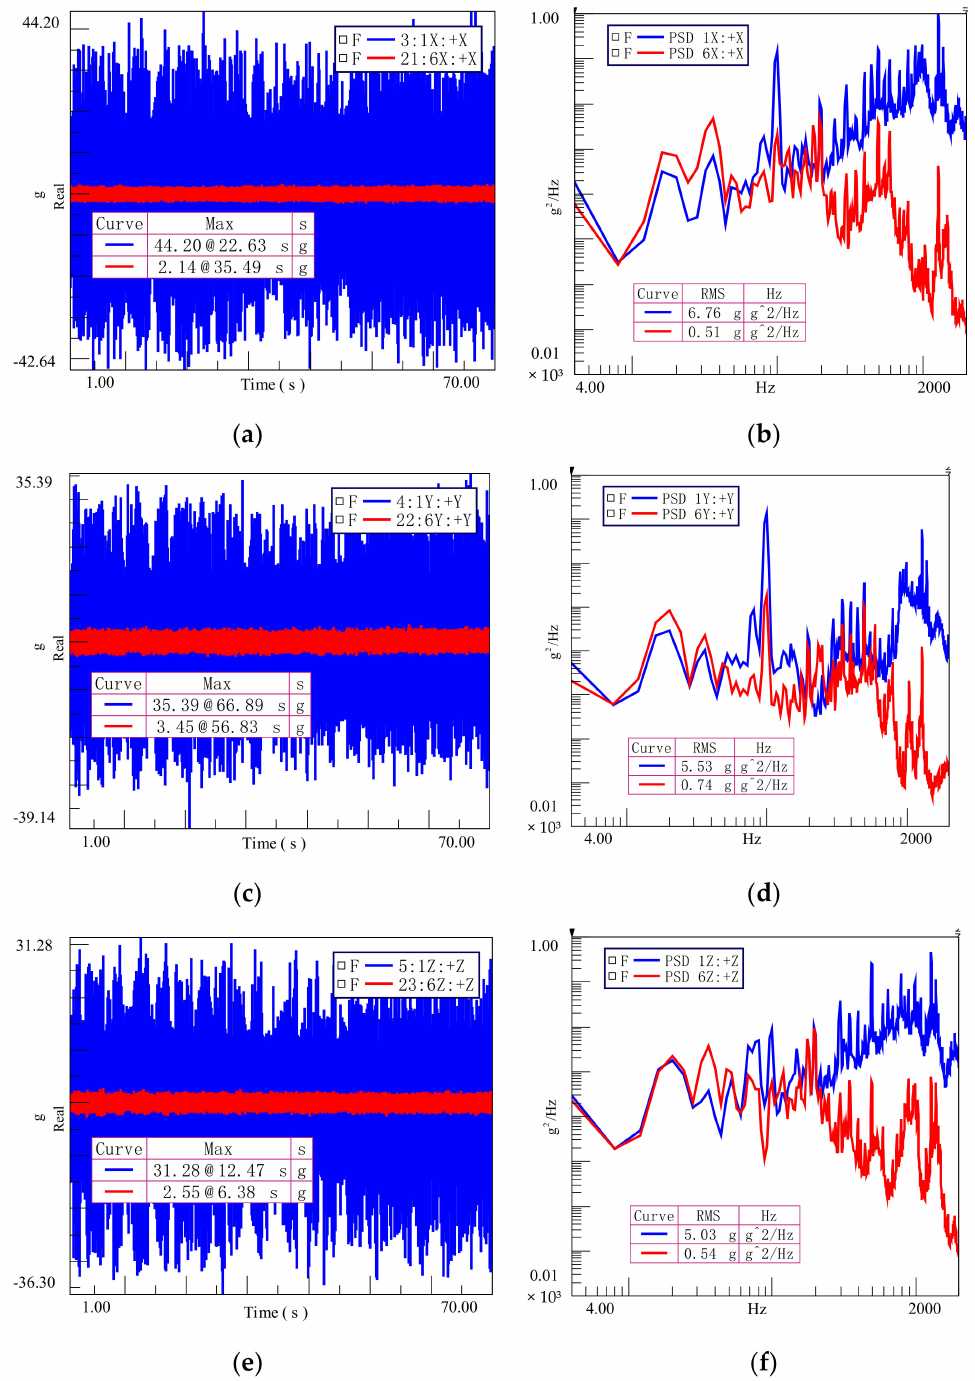
Figure 22. Time domain response and PSD (power spectral density) curve for acceleration in all directions: ( a ) Time domain response in the X direction; ( b ) Frequency domain response in X direction; ( c ) Time domain response in the Y direction; ( d ) Frequency domain response in Y direction; ( e ) Time domain response in the Z direction; ( f ) Frequency domain response in Z